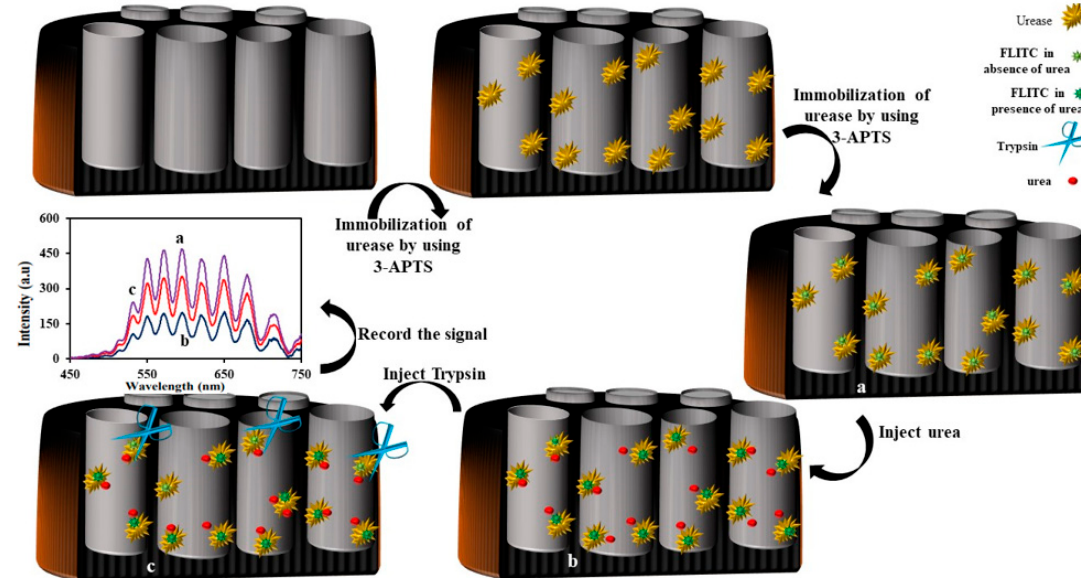
Figure 14. Schematic illustration showing the fabrication of the nanoanodic alumina-Urease- fluorescein 5(6)-isothiocyanate (NAA-Urease-FLITC) biosensor for the determination of trypsin using interferometric reflectance spectroscopy (IRS).